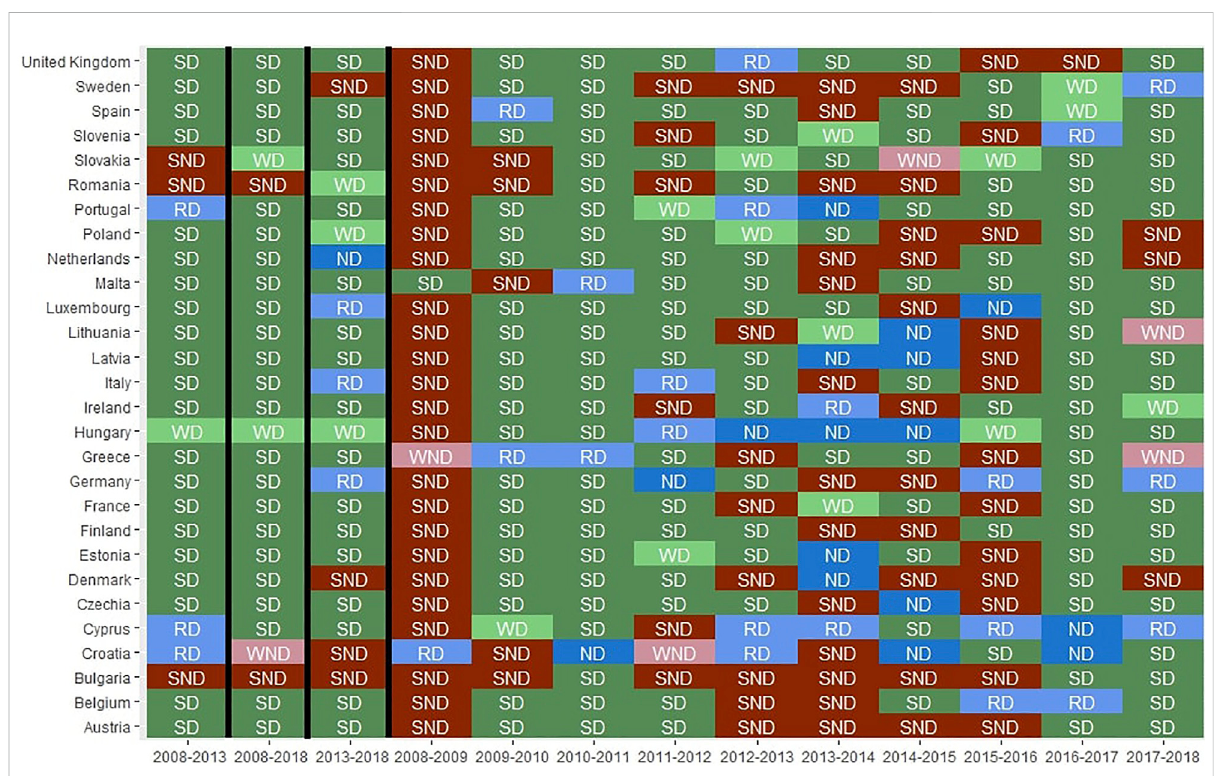
FIGURE 7 N 2 O intensity decoupling. Source: authors ’ calculation based on EEA,